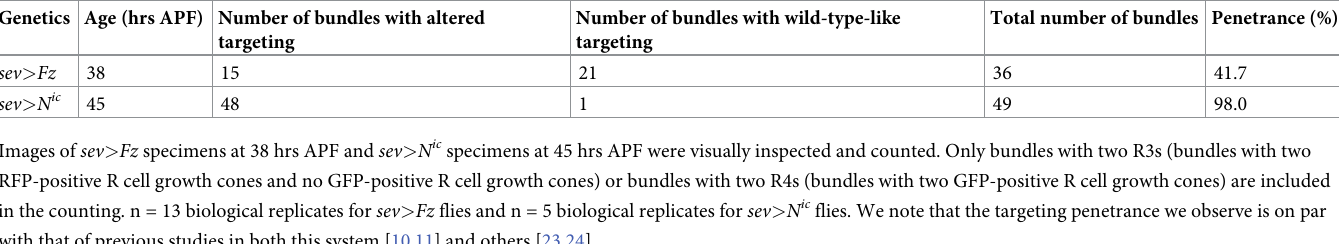
Table 1. Penetrance of target alteration of sev > Fz and sev > N ic . Genetics Age (hrs APF) Number of bundles with altered targeting